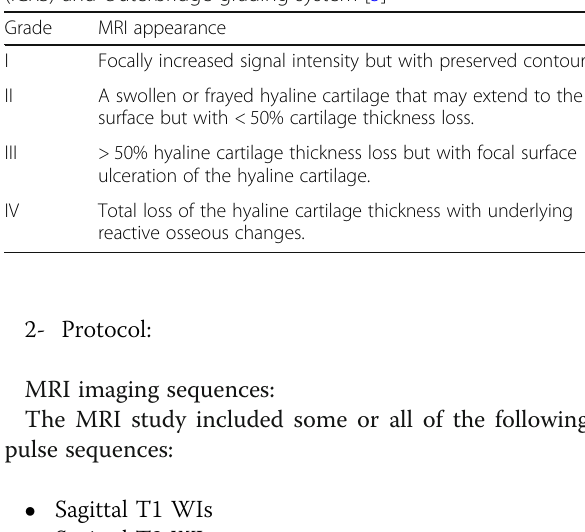
Table 3 Demonstrating the MRI grading of chondromalacia patella depending on the International Cartilage Repair Society